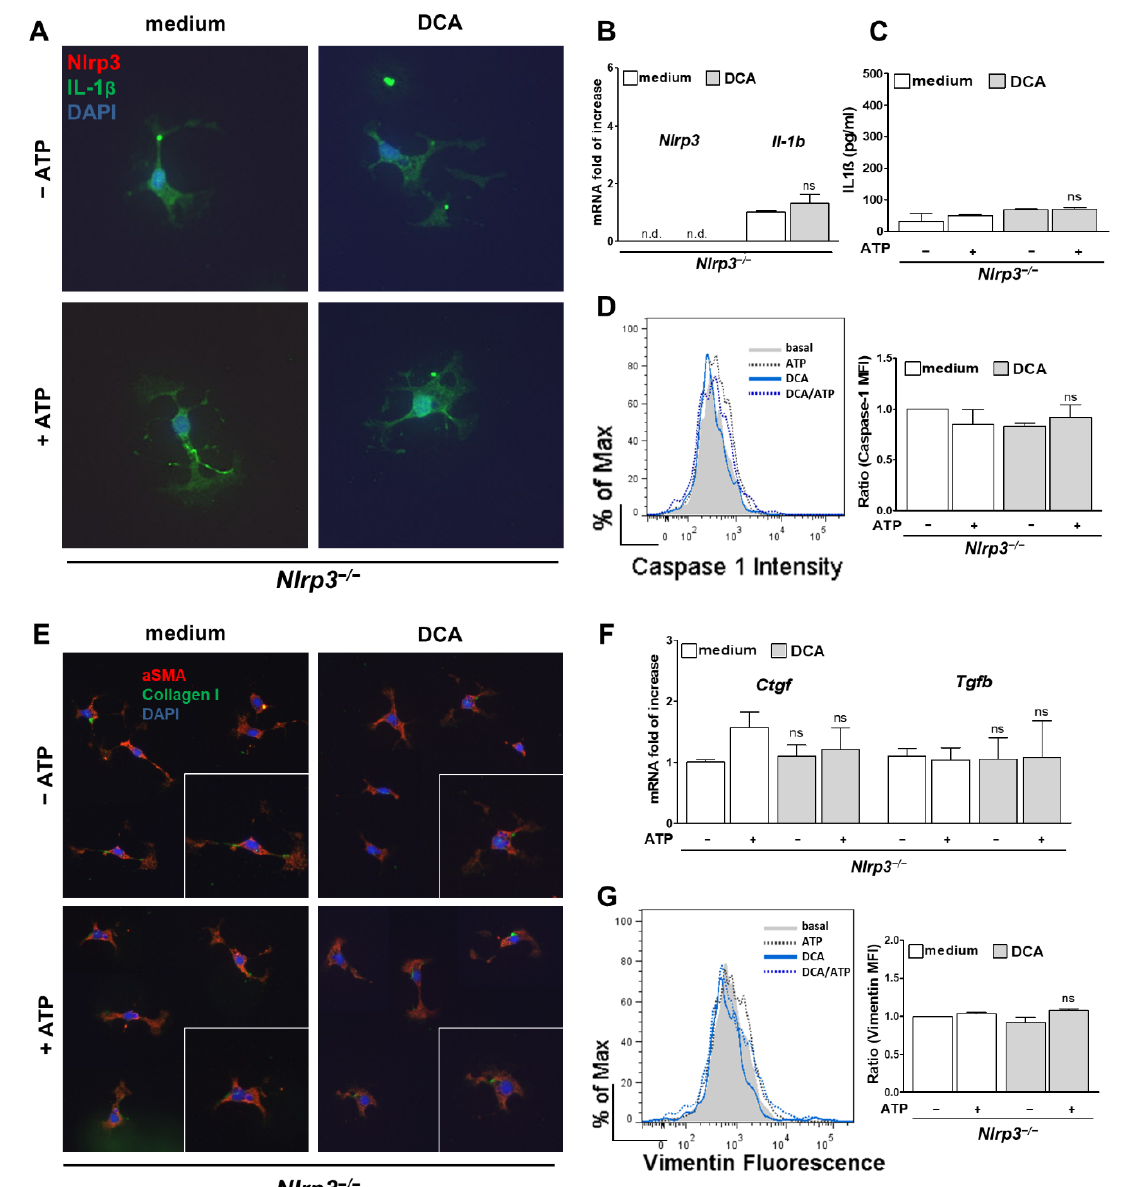
Figure 5. Stimulation of HSC from Nlrp3 − / − mice with DCA led to no fibrotic phenotype. HSC from Nlrp3 − / − mice showed no NLRP3 inflammasome activation after stimulation with DCA (+ ATP) as shown by stable mRNA levels of Il-1b ( B ), equal concentrations of IL-1 β in the supernatant ( C ), omitted formation of IL-1 β vesicles ( A ) and equivalent activity of Caspase-1 in flow cytometry analysis ( D ) when compared to basal levels. As a result, HSC were not activated to a fibrotic phenotype, as they failed to change their shape and deposit Collagen I ( E ) after DCA (+ ATP) stimulation. Early fibrotic markers such as Vimentin ( G ) and mRNA levels of Ctgf and Tgfb ( F ) remained the same. n.d.: not detected; ns: not